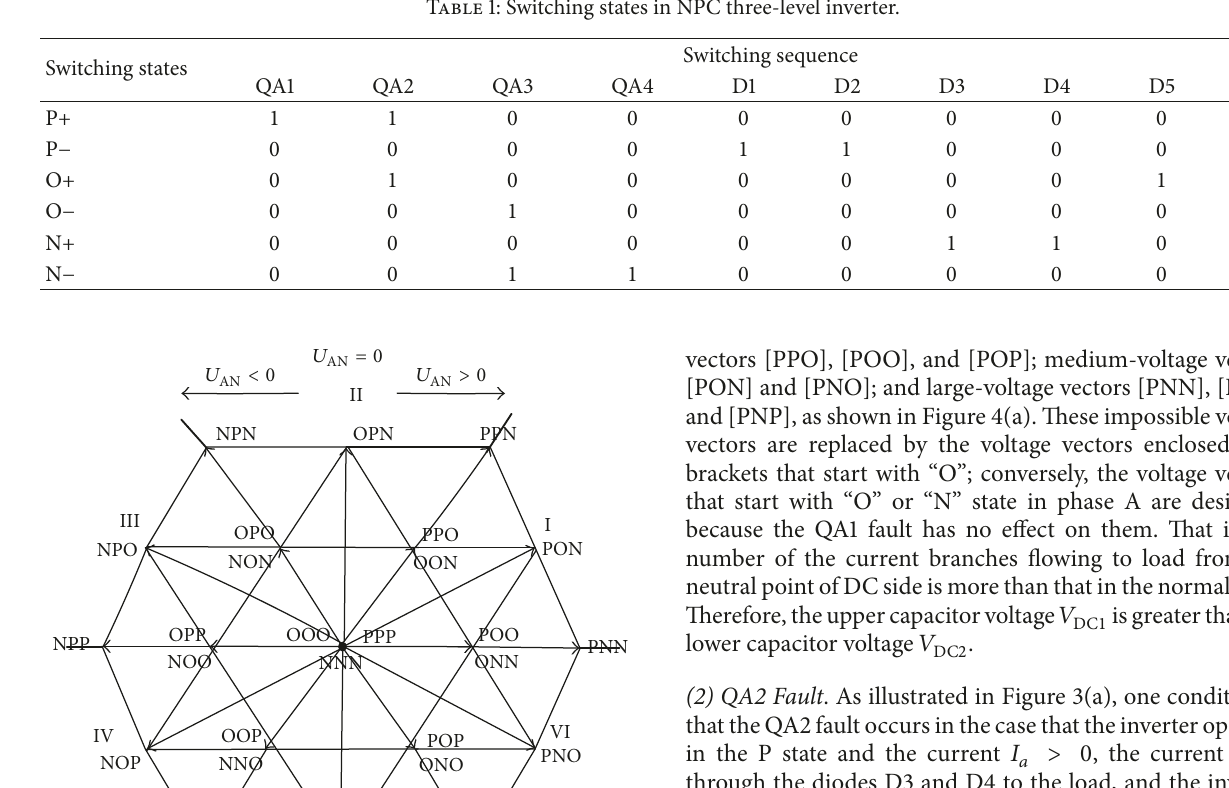
Table 1: Switching states in NPC three-level inverter.